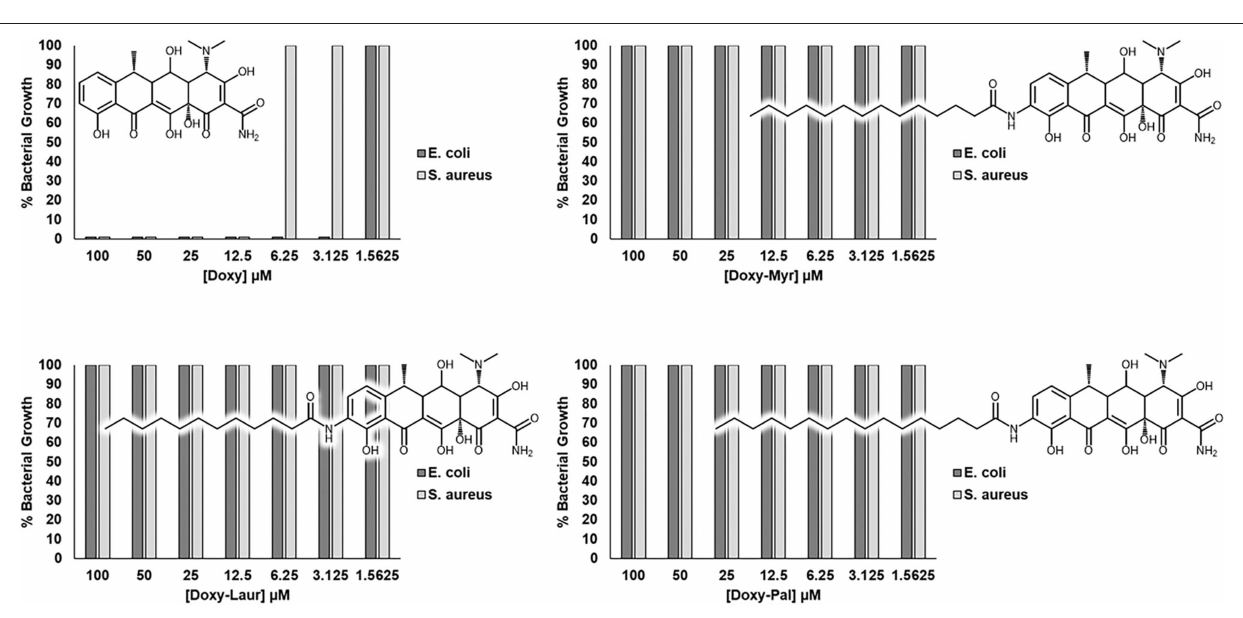
mg/L). The clinical breakpoints for tetracyclines against E. coli and S. aureus are between 0.5–2.0 mg/L and 2.0–6.0 mg/L, respectively